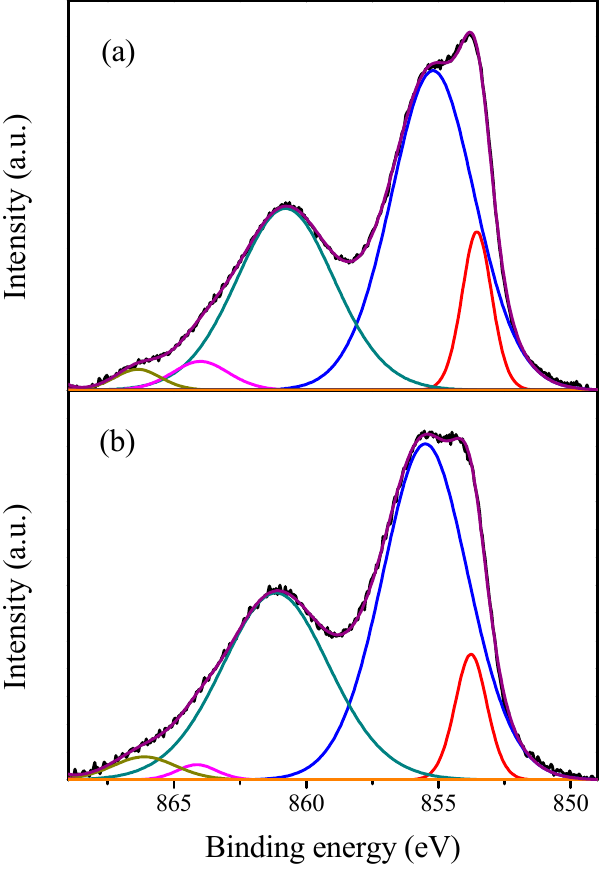
Figure 7. Ni 2p 3/2 XPS spectra of bare NiO ( a ) and Gd/NiO ( b ) catalysts. Table 2. Ni 2p 3/2 binding energies and their relative spectral areas of NiO and Gd/NiO catalysts. Ni Catalyst